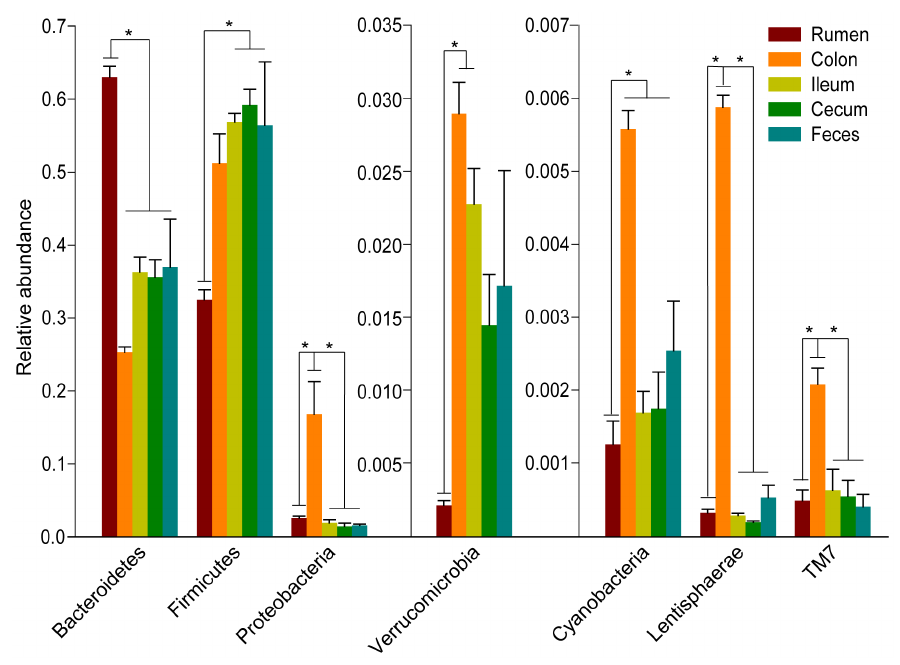
Figure 3. Bacterial phyla with significant differences in the GITof three roe deer. The asterisk means the significance at P , 0.05.